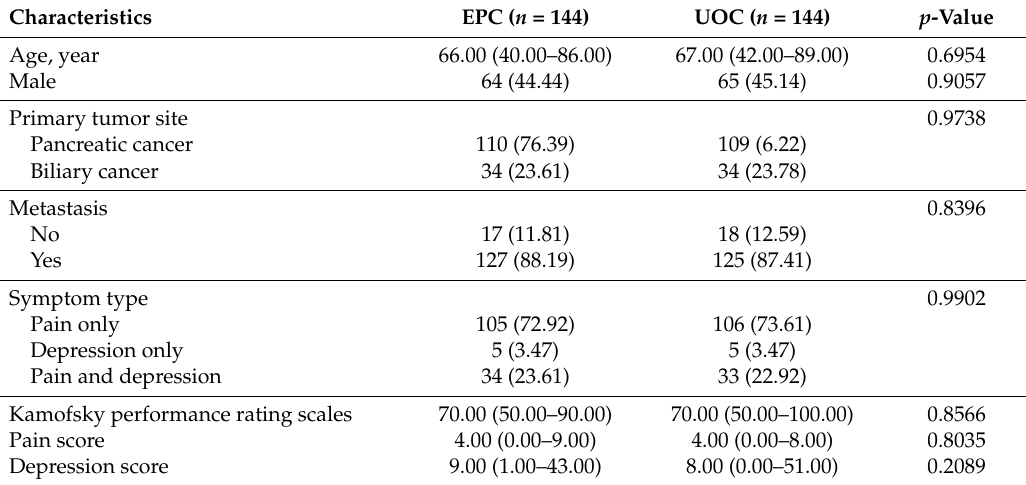
Table 1. Baseline